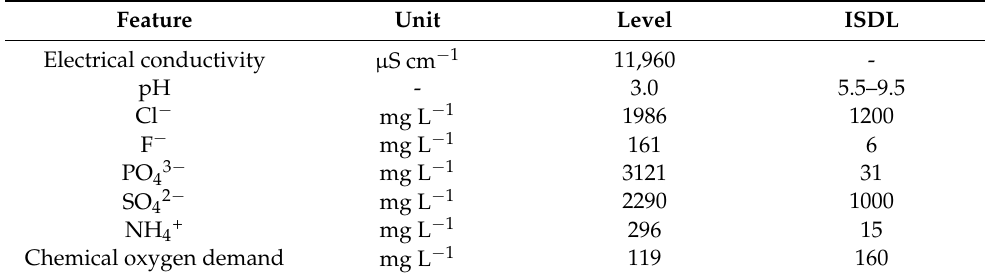
Table 3. Wastewater physical-chemical characterisation and Italian surface discharge limits (IS- DLs)